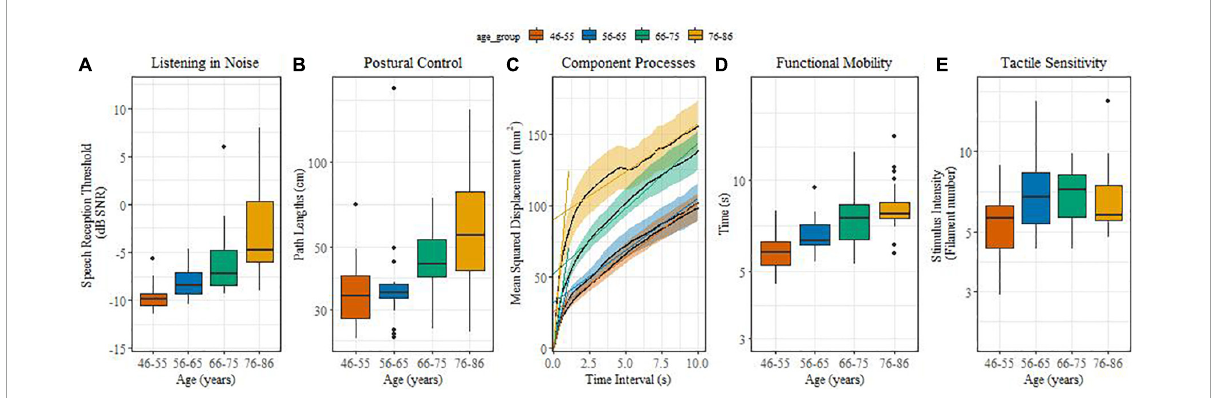
FIGURE1 (A–E) (boxplots): Effect of age on sensory and sensorimotor processes. (A) Listening in noise in noise; (B) Postural control; (C) Component processes; (D) Functional mobility; (E) Tactile sensitivity.